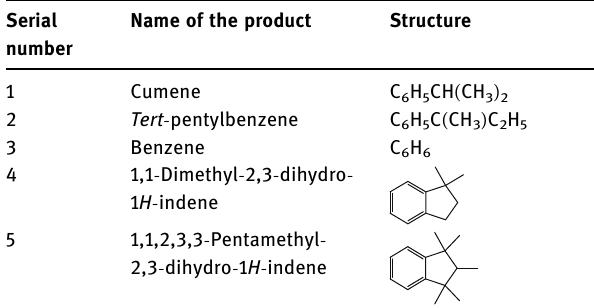
Table 1: Qualitative analysis of the reaction products